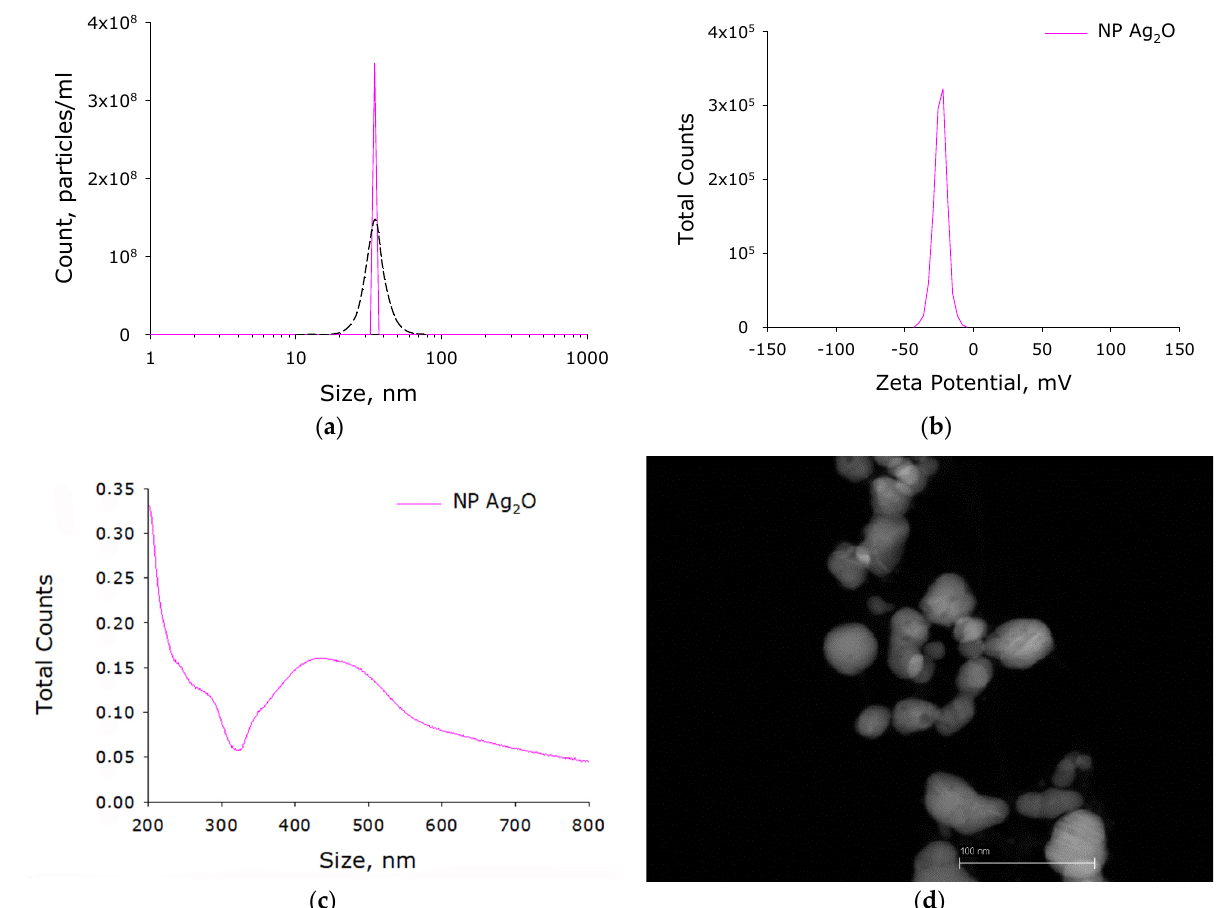
Figure 3. Physicochemical properties of silver oxide NPs. ( a ) Concentration (DLS, solid crimson line) and size distribution (CPS, black dashed line) of silver oxide NPs. ( b ) ζ -potential of Ag 2 O NPs. ( c ) Example of absorption spectrum of colloidal solution of Ag 2 O NPs. ( d ) Example of Ag 2 O NPs TEM image.